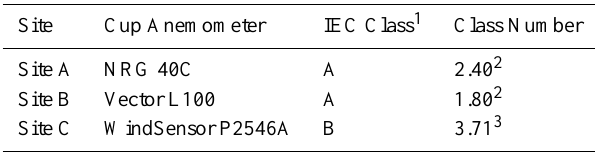
Table 2. Uncertainty classification of the cup anemometers used at the three